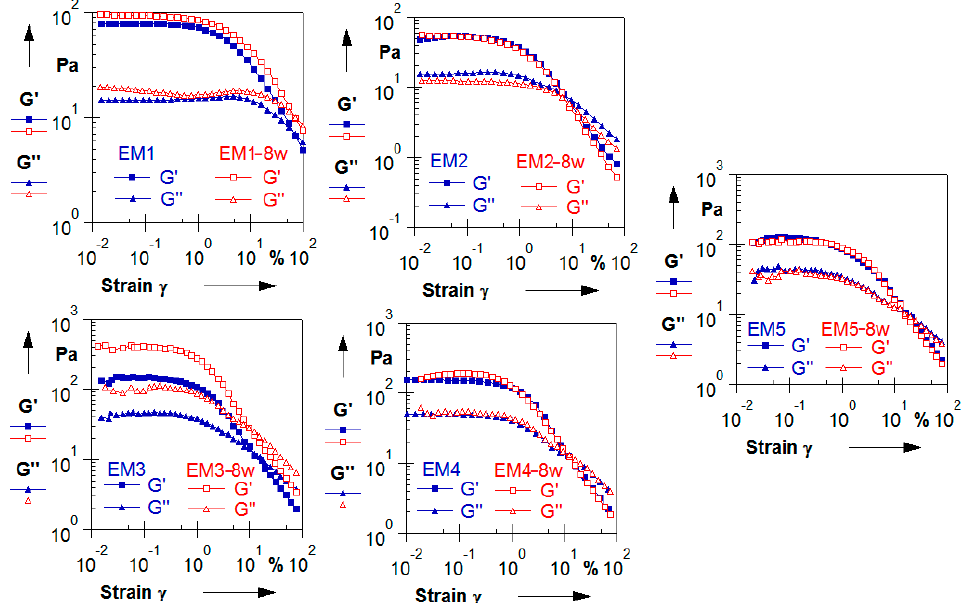
Figure 4. G’ and G” dependencies on strain amplitude, measured at constant angular frequency 1 rad/s. Error bars for the measured values are within the size of point markers.